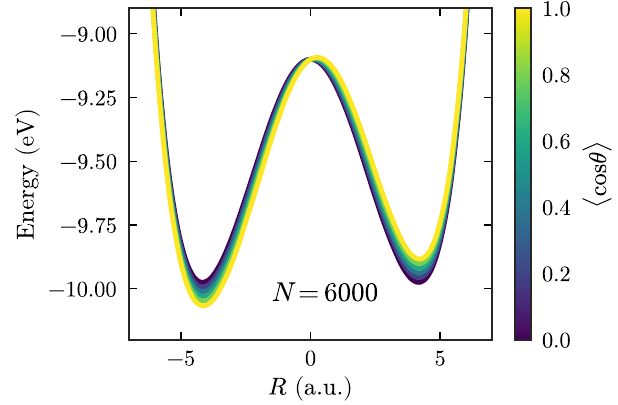
FIG. 9. Alignment dependence of the cavity Born-Oppenheimer PES along the photonic minimum path q in Fig. 8(c), with all other molecules fixed to the equilibrium position R min